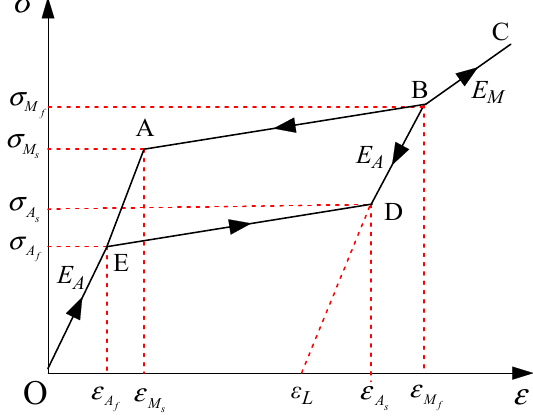
Figure 3. Flag-shaped hysteretic model of an SMA wire.